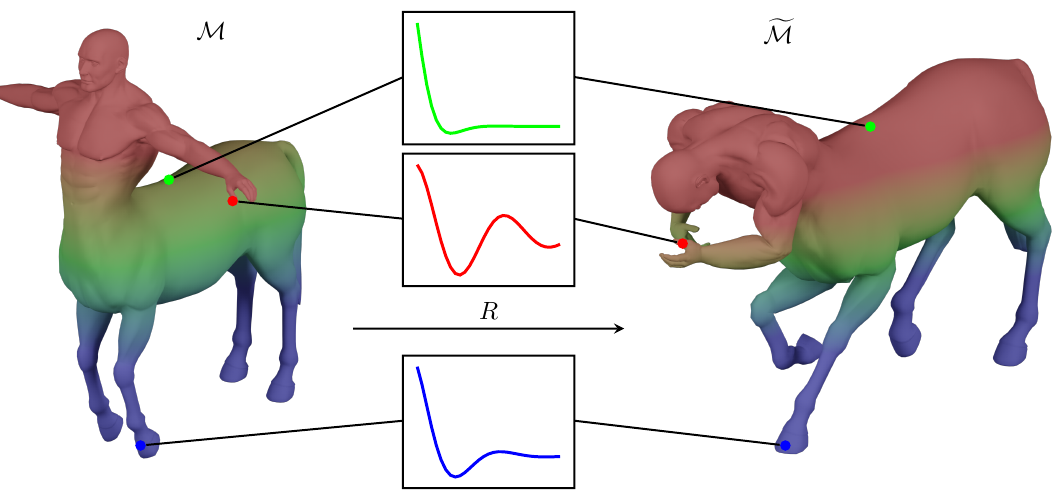
Figure 1. Almost isometric transformation T between two centaur shapes (shape 2) of the TOSCA dataset [2]. Additionally, we see the feature descriptor (function plots M in the boxes) at three different points x i with i (cid:102) thumb, the back and the left front hoof, in this order. The plotted feature descriptors are created for illustration of the underlying idea and are not based on real